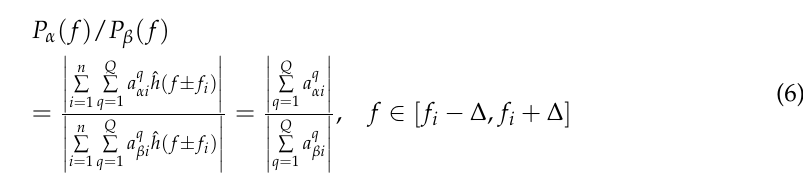
Table 1. Variable definitions involved in the problem statement.